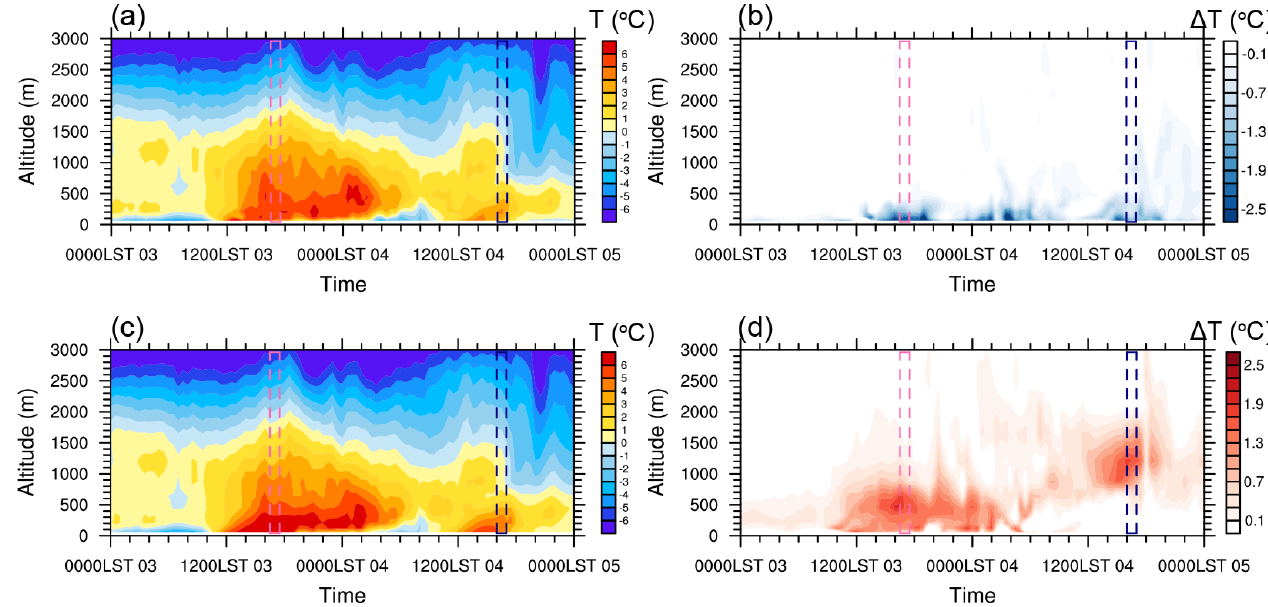
Figure 9. Temporal evolution of temperature profile with (a) high aerosol emissions (EXP_WF20Aer) and (c) high BC emissions (EXP_WF20Aer). The temporal evolution of the temperature variation profile influenced by (b) high scattering aerosol loadings (EXP_WF20Aer – EXP_WF20BC) and (d) high absorbing aerosol loadings (EXP_WF20BC – EXP_Ctrl). The pink and blue dashed boxes correspond to the aircraft observation periods on 3 and 4 January,